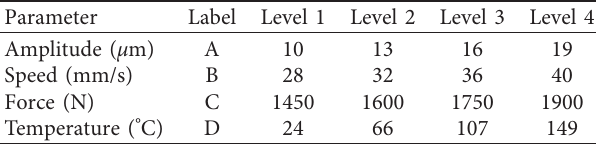
Table 2: Process parameters and levels selected [5].